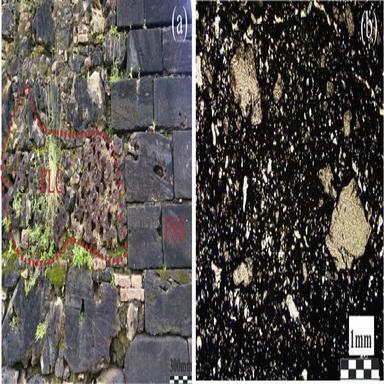
(a) Blocks of FLC dispersed on the face of the N. Srª. da Conceição bulwark highlighted in the contour with columnar/tubular crusts arranged horizontally. (b) Photomicrograph of FLC (sample SJ.R.12/14: face of the N. Srª. da Conceição bulwark), in which are observed a quartz distribution and an oxyhydroxide matrix of Fe and clay minerals.